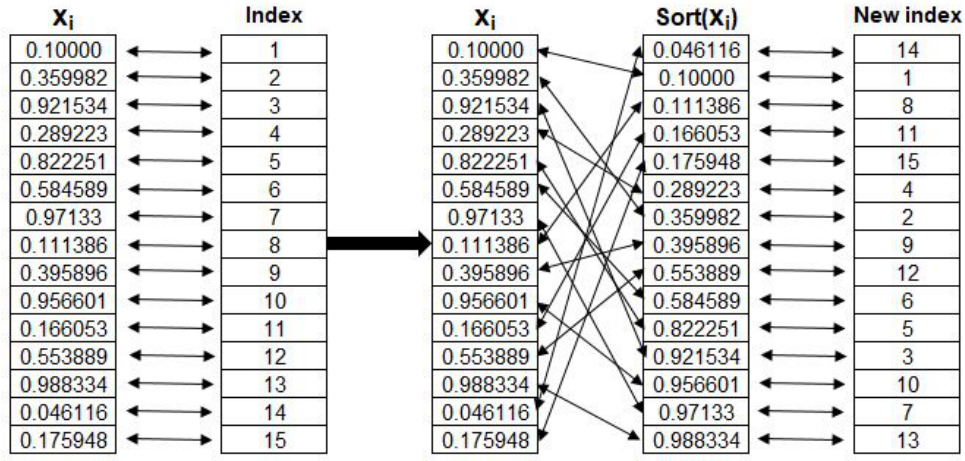
Figure 3. Generate random various values between 1 and 15 using logistic map x i + 1 = 3.9998 x i ( 1 and x 0 =